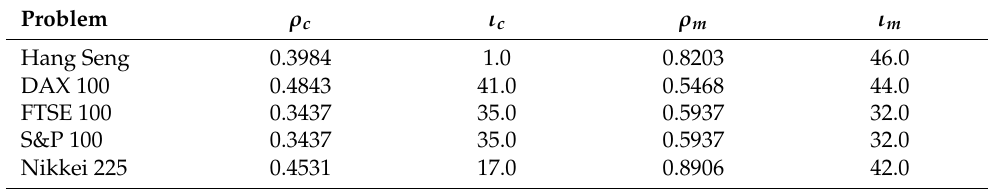
Table 3. Optimal control parameter values for the non-dominated sorting genetic Algorithm 2.